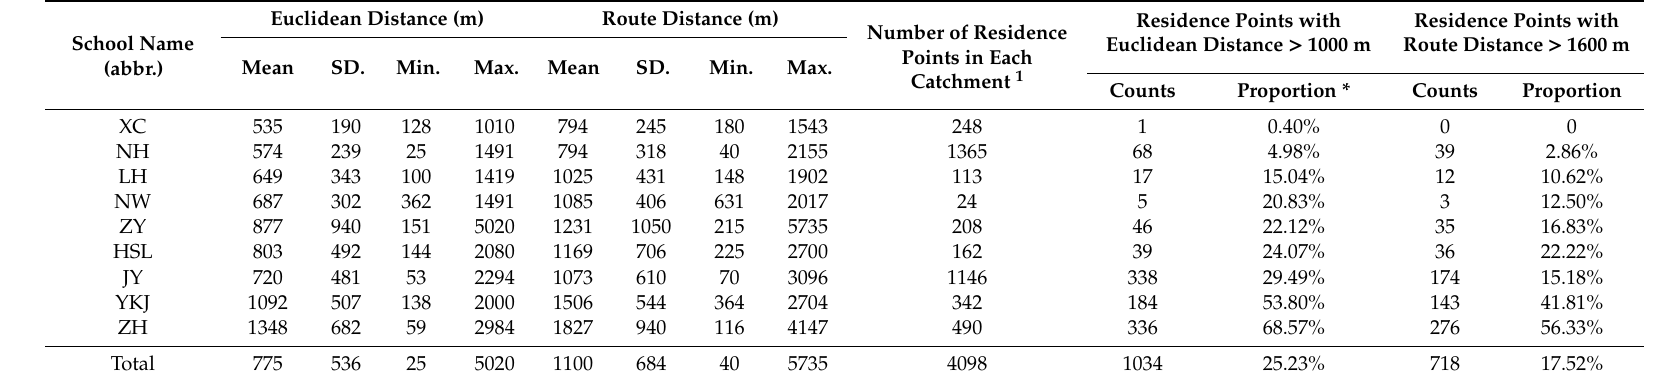
1 residence points: one point refers to one residence building. * Table sorted by this